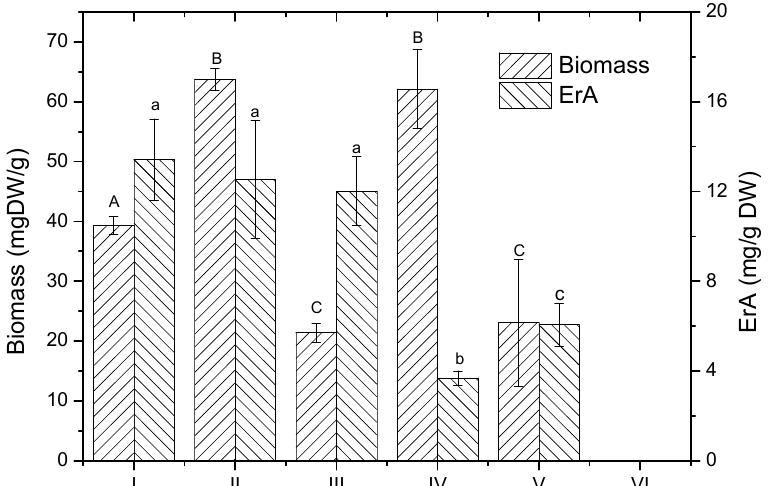
Figure 4. The effect of different substrates on the mycelial biomass and specific yield of ErA. I. polished rice, II. corn kernel, III. adlay kernel, IV. brown rice, V. red beans, VI. sesame. Different superscripts in the upper case indicate significant difference ( p < 0.05) in biomass, and different superscripts in lower case indicate significant difference ( p < 0.05) in specific yield of ErA.